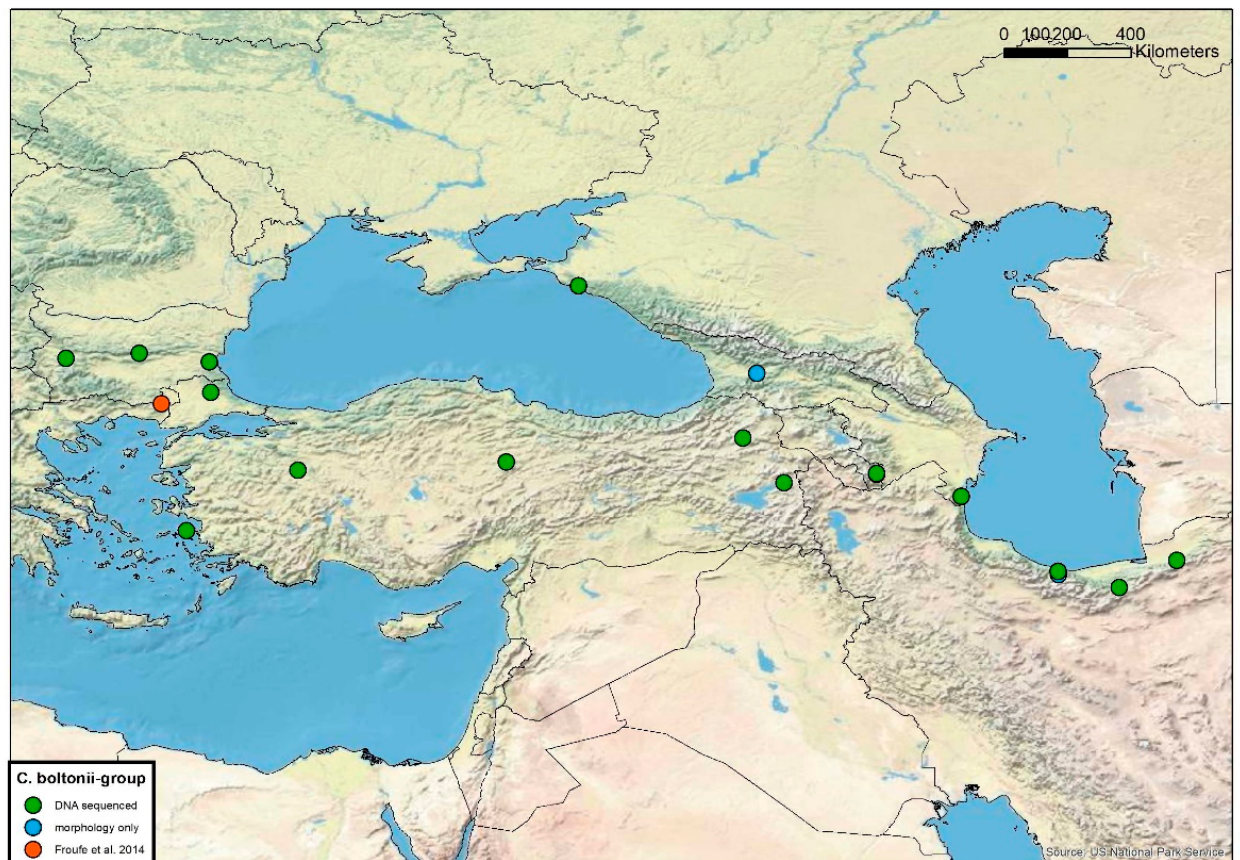
Figure 1. Map showing the origin of investigated specimens of the C. boltonii -group.